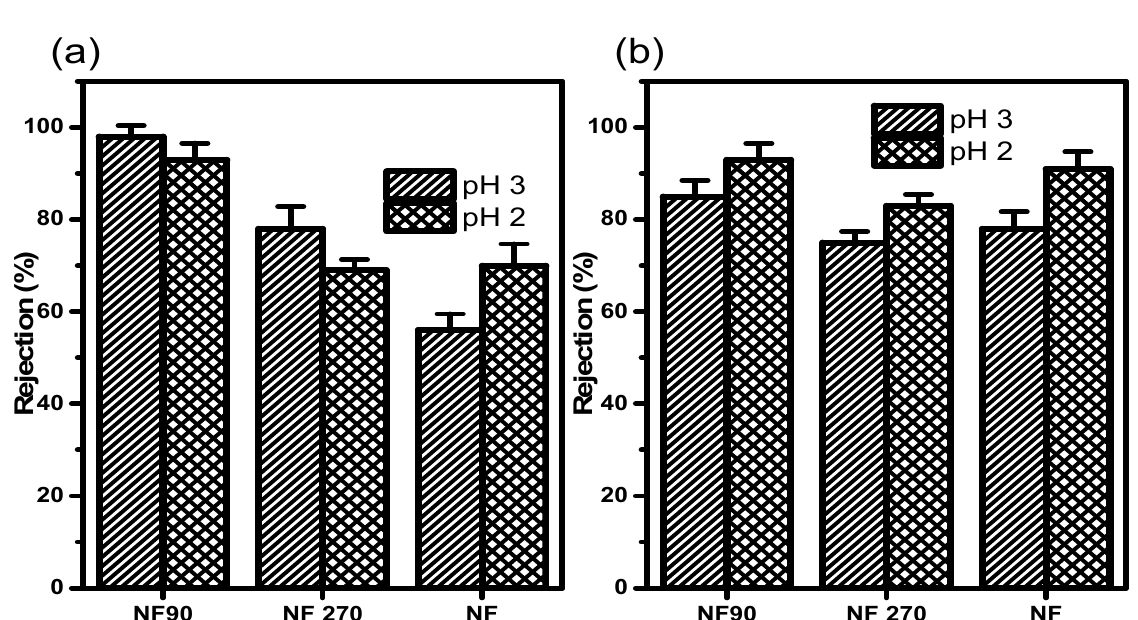
Figure 7. Rejection of ( a ) Cu + in a 200 ppm CuCl solution at 5 bar and ( b ) Ag + in a 200 ppm AgCl solution at 5 bar.